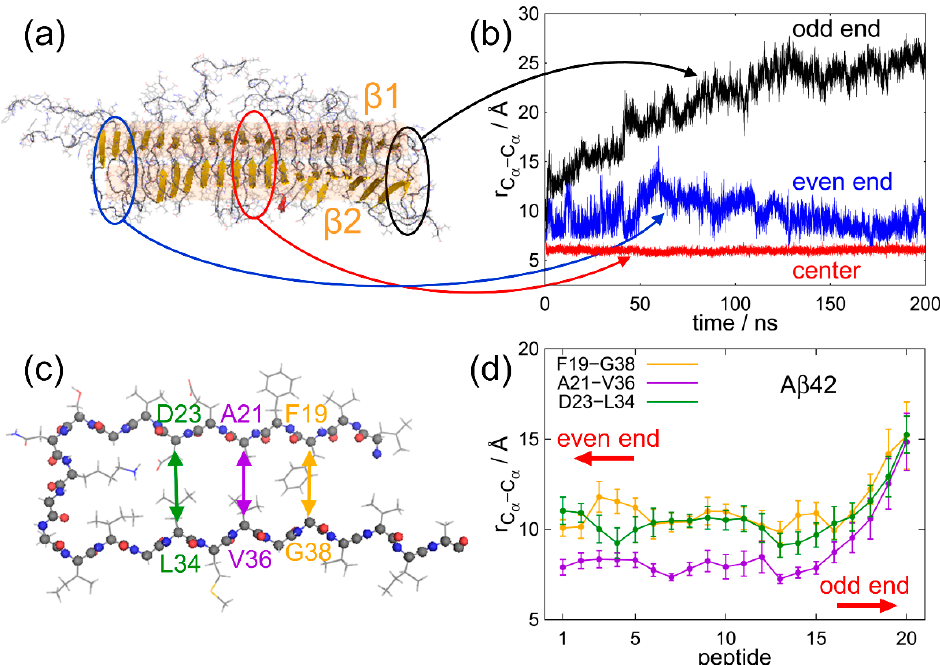
Figure 10. ( a ) A snapshot of the A β 42 amyloid fibril in the MD simulation. ( b ) Time series of C α –C α distance between A21 and V36 at the odd end, in the center region, and at the even end. ( c ) Side view of chain C of model 1 of the PDB conformation (PDB ID: 2BEG) of the A β 42 amyloid fibril. ( d ) The average C α –C α distances of the A β 42 amyloid fibril between F19 and G38 (orange), A21 and V36 (purple), and D23 and L34 (green). Panels ( a , c ) were created using PyMOL [171]. Reprinted with permission from Ref. [72]. Copyright 2016 Springer Nature.